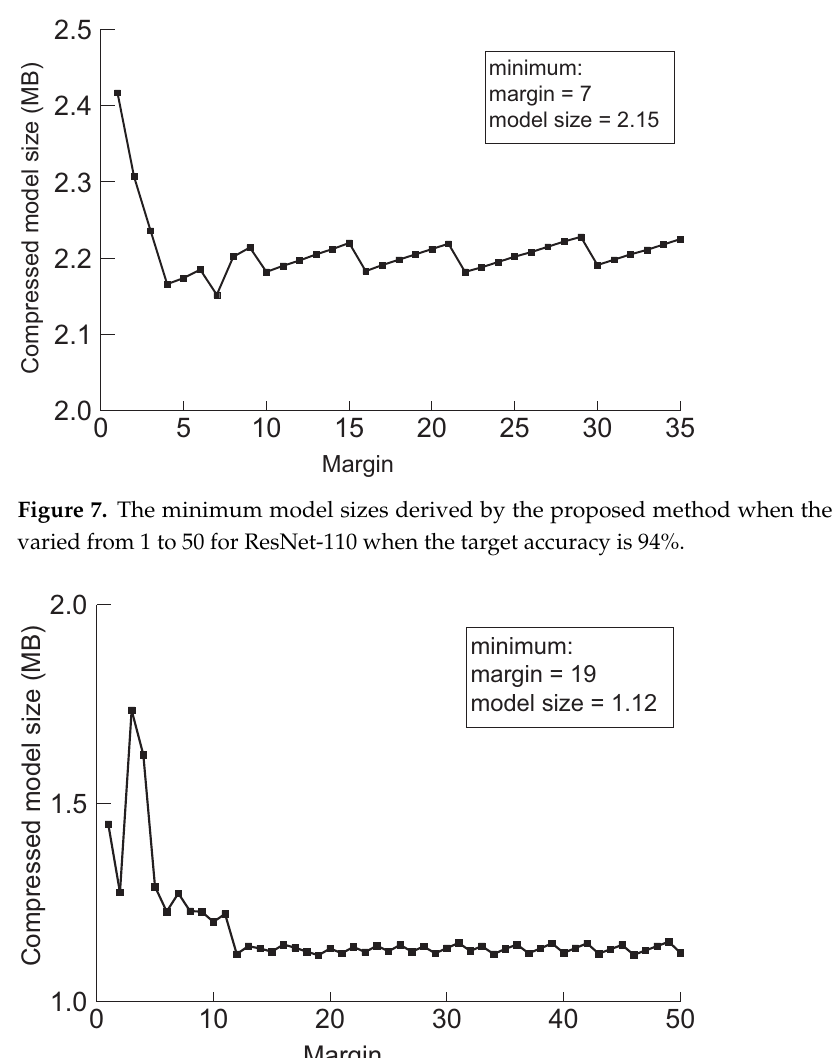
Figure 6. The minimum model sizes derived by the proposed method when the initial margin is varied from 1 to 50 for VGG-19 when the target accuracy is 92%.